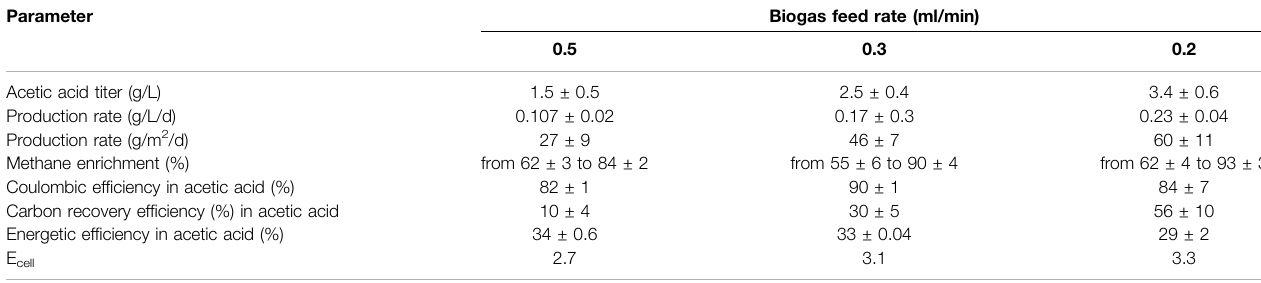
TABLE 1 | Comparison of key production parameters at different biogas feed rates.